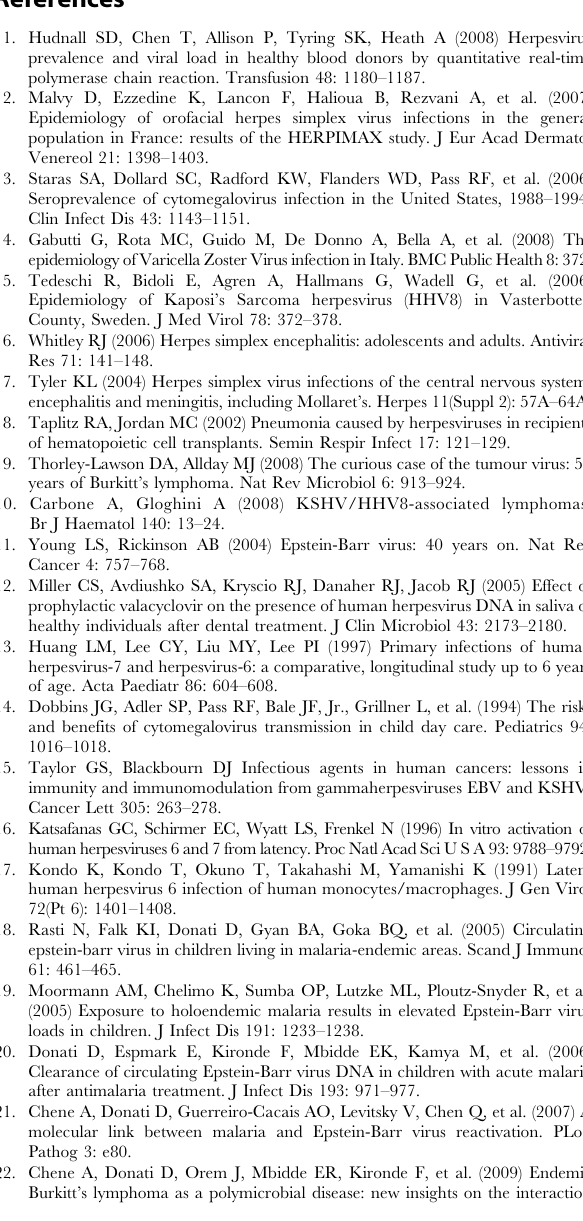
Table S1 Clinical characteristics of the patients. Clinical characteristics of the patients belonging to the M + group and the M 2 group. ‘‘ 2 ‘‘indicates that the data are missing or not determined. Table S2 HHVs loads in saliva and plasma. HHVs load (viral DNA copies/mL) in plasma samples (P) and saliva (S) from children with acute malaria before and after anti-malarial treatment and in children having mild infections unrelated to malaria. All samples with less than 200 viral copies/mL were